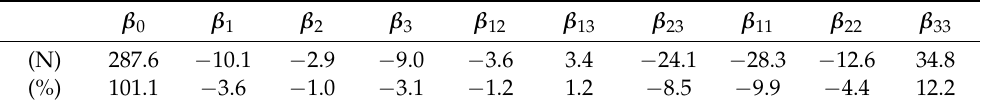
Table 3. Regression coefficients for the P max response considering x 1 , x 2 , x 3 (in codified units) and f out in N and percentage over the mean P max value.